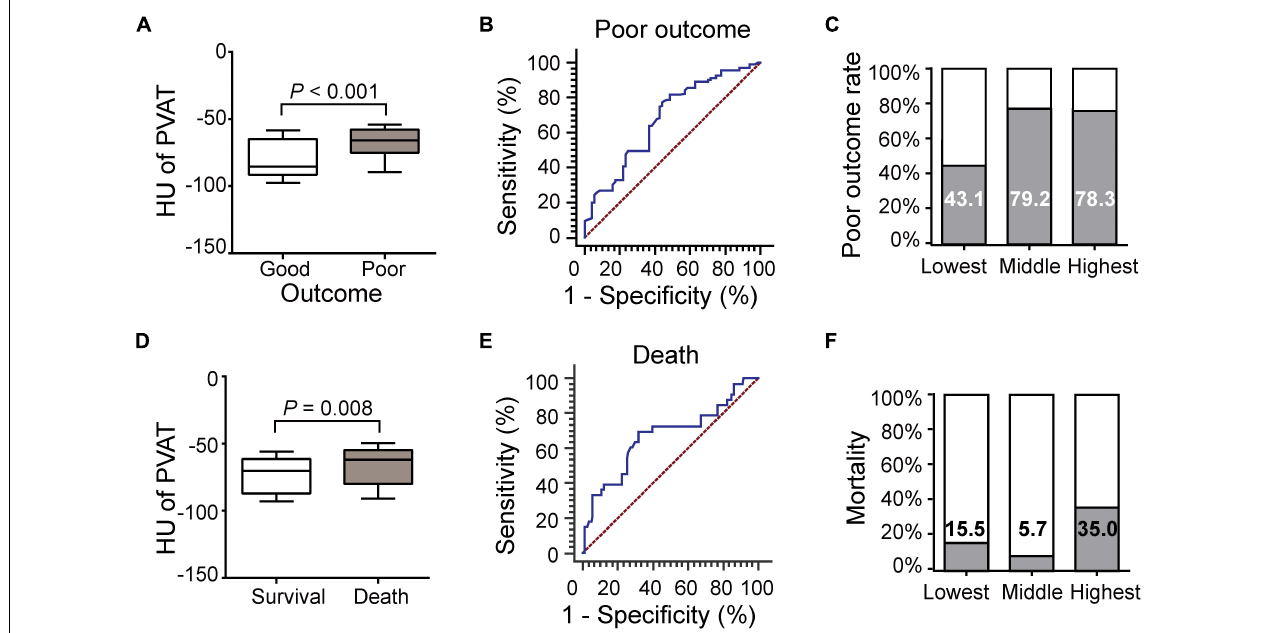
FIGURE 3 | Association of carotid artery PVAT density with 3-month functional outcome and mortality. (A) Comparison of patients with good or poor outcomes. (B) ROC analysis assessing the prognostic accuracy for poor outcome. (C) Poor outcome rates based on the PVAT classification. (D) Comparison of patients with death and survival. (E) ROC analysis assessing the prognostic accuracy for death. (F) Mortality based on PVAT classification. HU, Hounsfield units, PVAT, Perivascular adipose